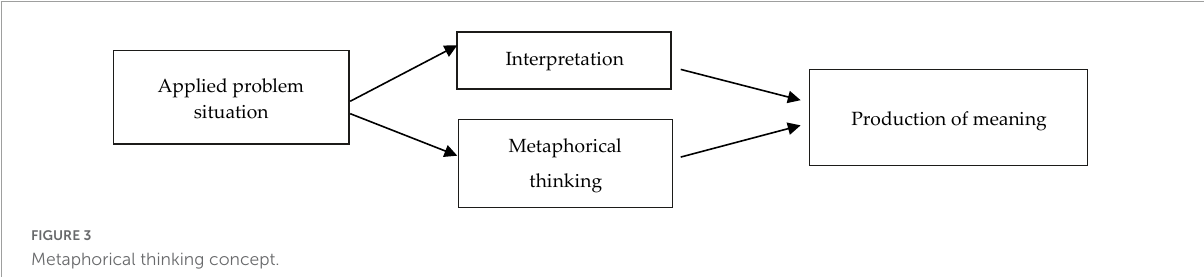
FIGURE3 Metaphorical thinking